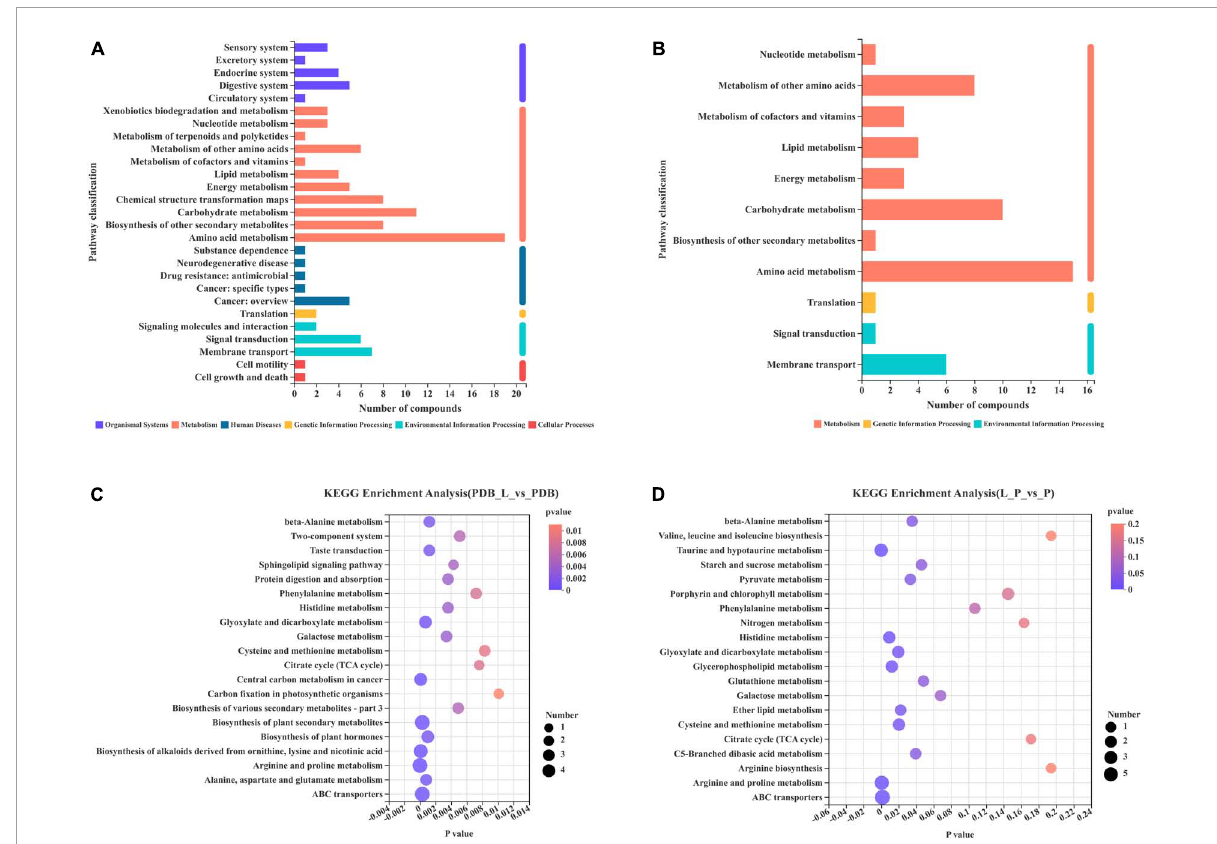
FIGURE8 Differential metabolites involved in each metabolic pathway and the number of metabolites. The 20 most abundant metabolic pathways enriched by KEGG (A,C) PDB_L vs. PDB groups; (B,D) L_P vs. P